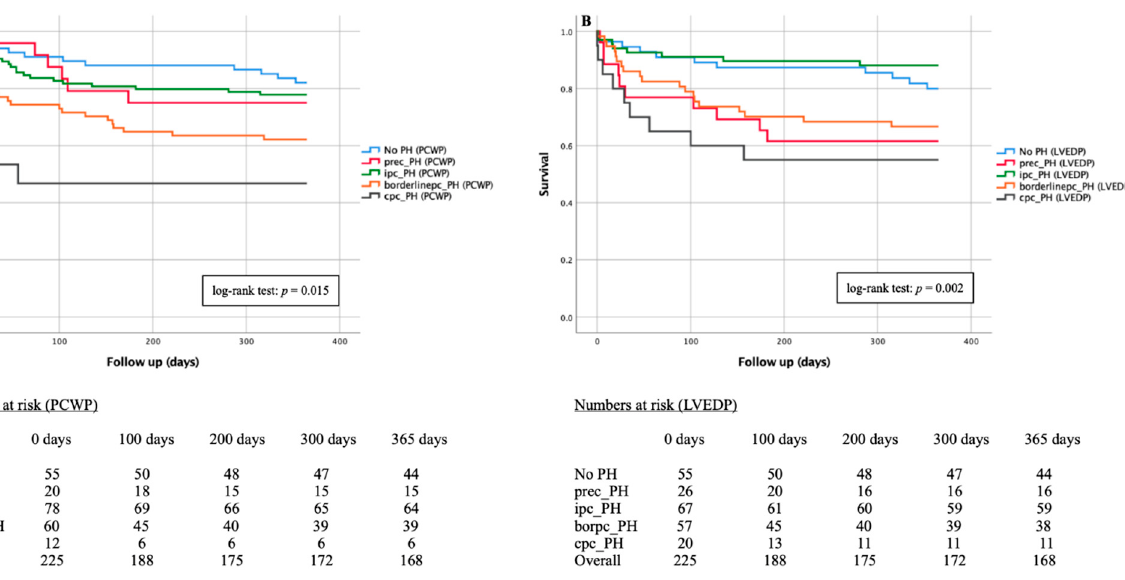
Figure 4. Kaplan-Meier curves of 1-year mortality with associated numbers at risk in patients with severe AS classified in PCWP- and LVEDP-PH-subtypes. ( A ) Comparison of No PH vs. PCWP-PH-subtypes; ( B ) Comparison of No PH vs. LVEDP-PH-subtypes. Prec-PH: pre-capillary pulmonary hypertension; Ipc-PH: isolated post-capillary pulmonary hypertension; Borderlinepc-PH: borderline post-capillary pulmonary hypertension; Cpc-PH: combined post- and pre-capillary pulmonary hypertension.